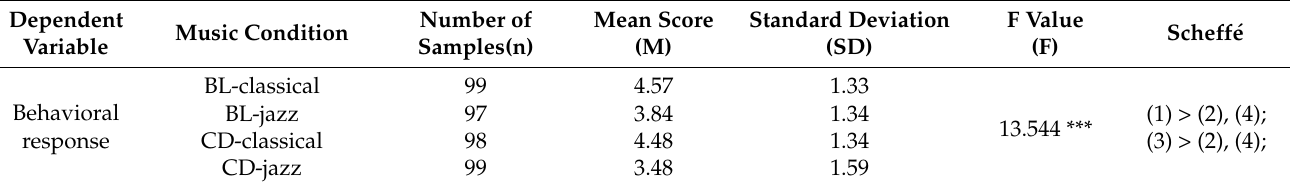
Table 7. One-factor ANOVA of the behavioral responses to different musical conditions ( n = 393).